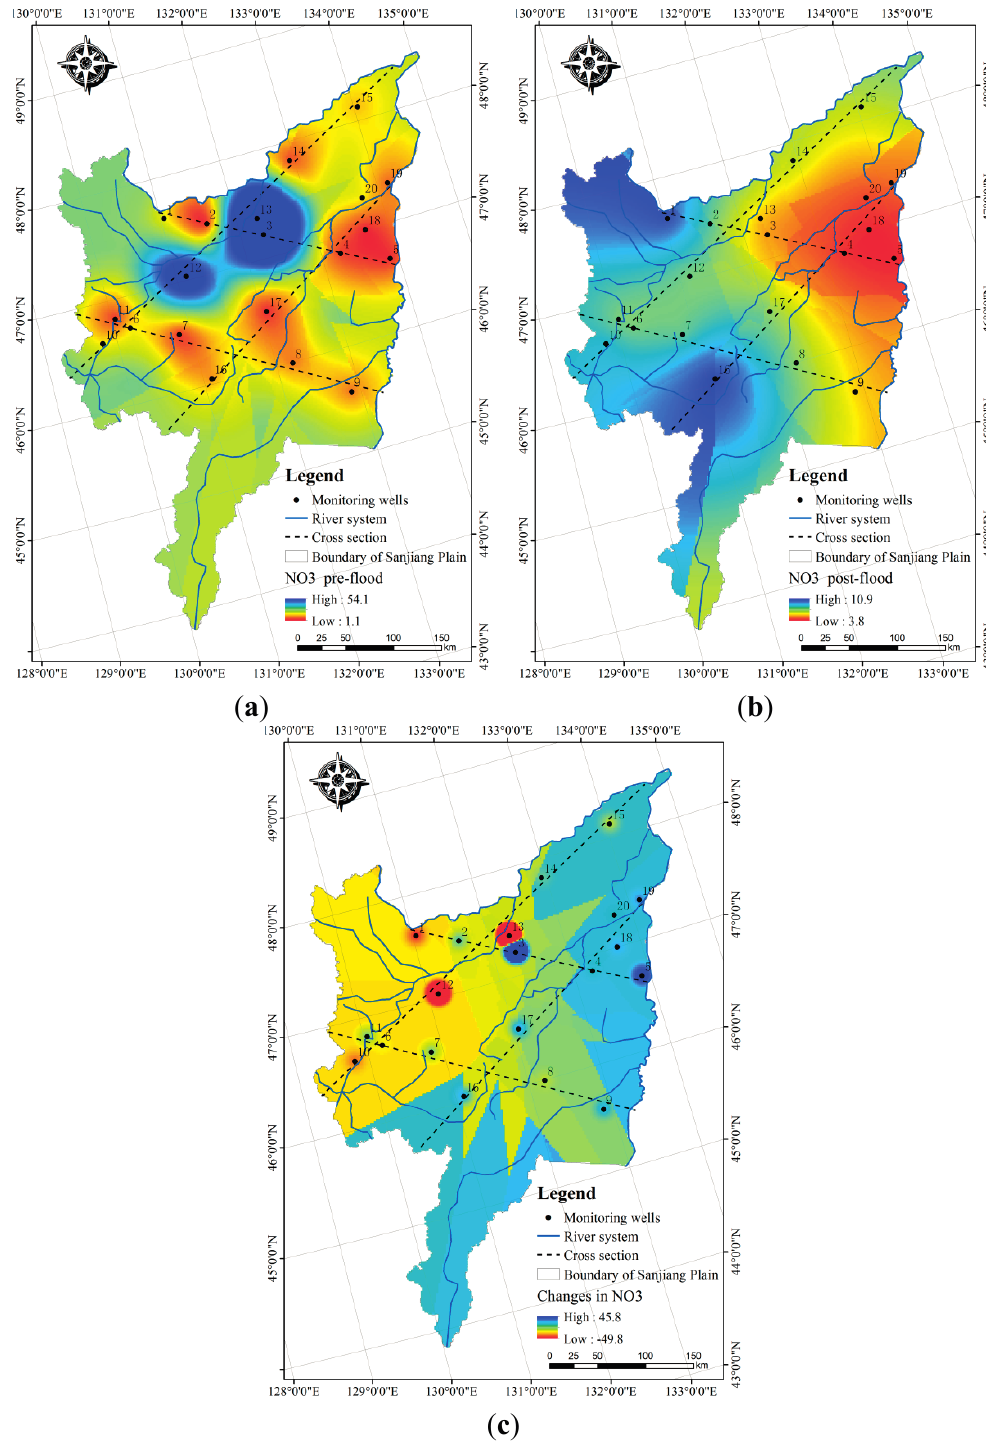
Figure 6. Changes in shallow groundwater nitrate nitrogen following the 2013 summer flood in the Sanjiang Plain, Northeast China: ( a ) pre-flood; ( b ) post-flood; and ( c ) changes between pre- and